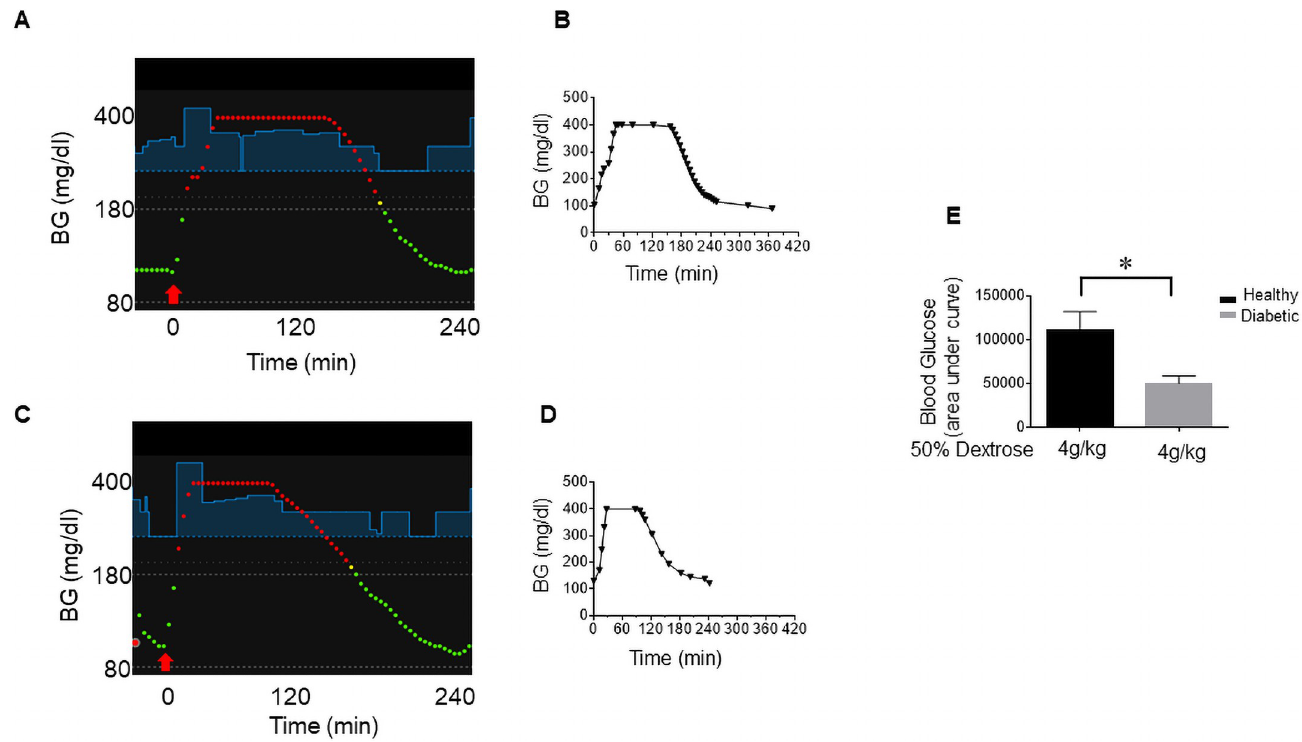
Fig 6. BGL after intraperitoneal injection of 4 g/kg 50% dextrose in healthy and diabetic rats. (A) and (C) Representative Nightscout images of BGL for healthy (n = 3) and diabetic (n = 3) rats, respectively, are shown. The red arrow shows the time of injection. Blue lines show suggested insulin infusion by OpenAPS. BGL above 200 mg/dl and below 180 mg/dl are shown in red and green dots, respectively. (B) and (D) BGL determined by Contour Next glucose meter (closed circles) and Enlite sensor (closed inverted triangles) for healthy and diabetic rats, respectively. (E) Area under curve for BGL determined by the glucose meter for healthy and diabetic rats. Values are presented as means ± SEM (n =